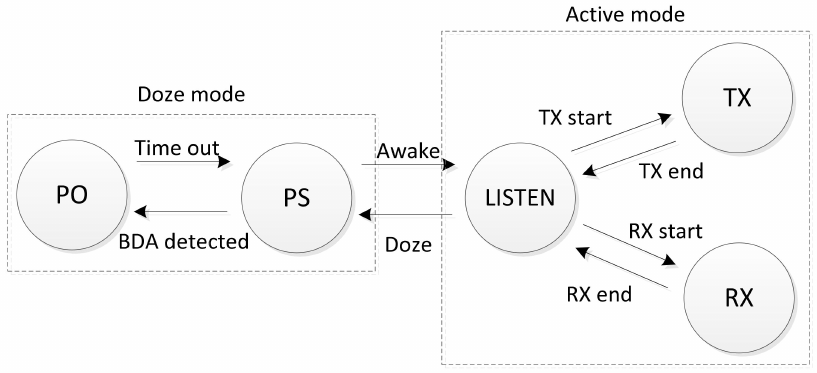
Figure 9. Wi-Fi power state